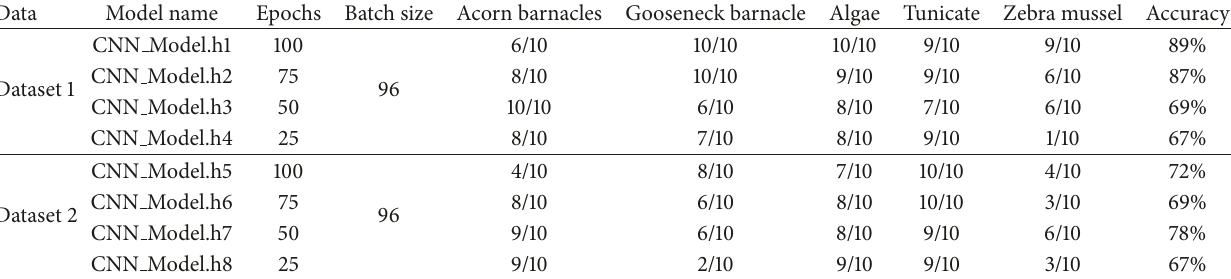
Table 7: CNN models test